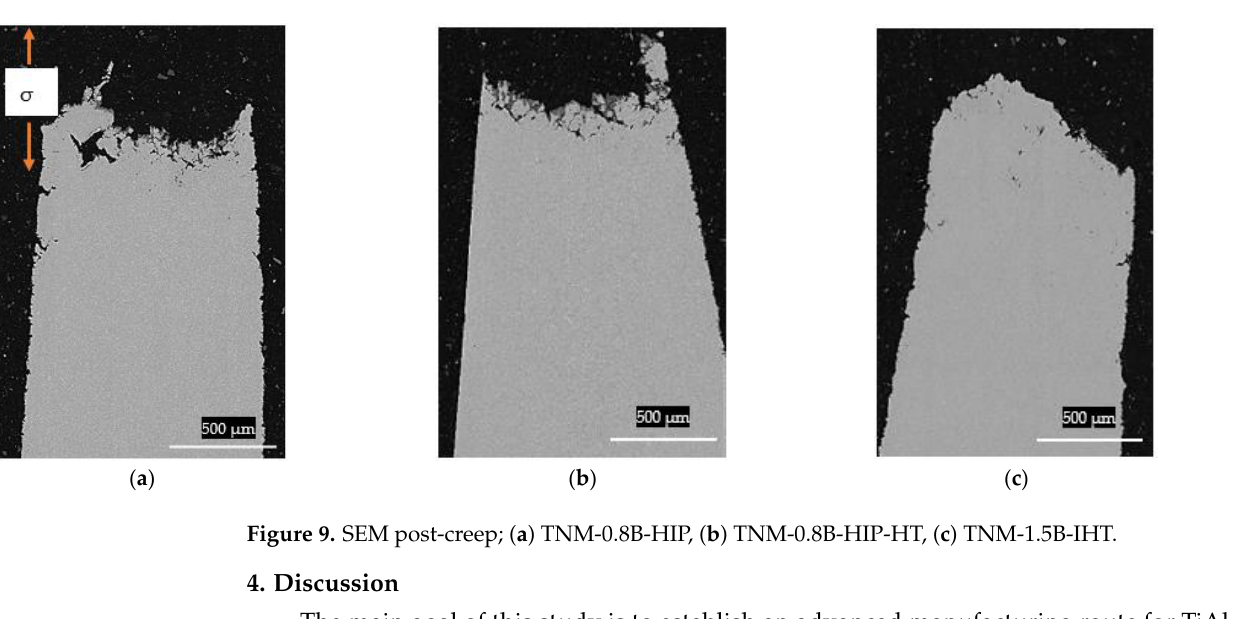
( b ) Figure 8. SEM; ( a ) TNM-0.8B-HIP tensile test fracture at room temperature, ( b ) TNM-0.8B-HIP post- creep fracture (750 °C, 250 MPa).